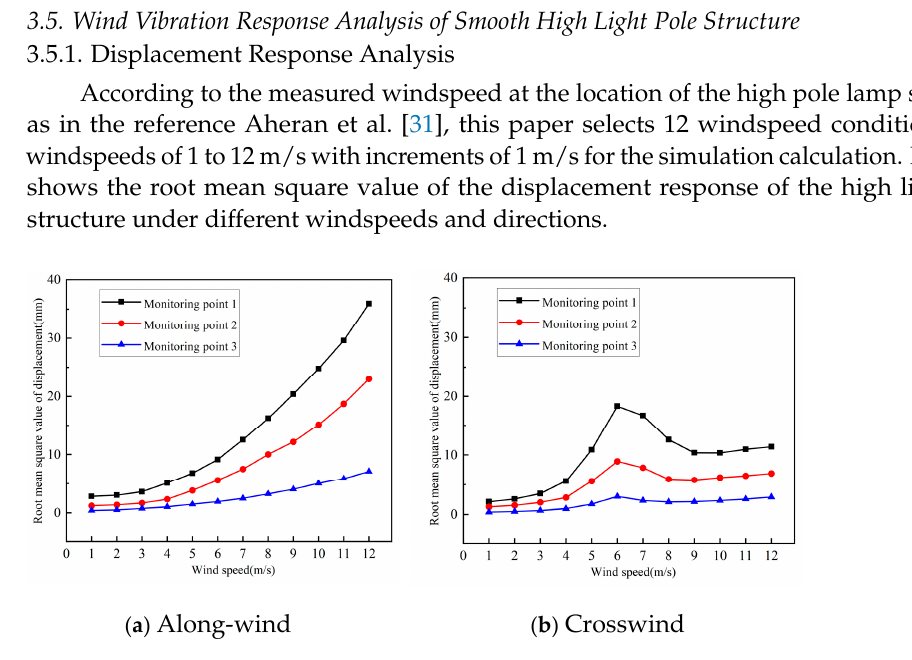
Figure 12. Root mean square value of displacement responses of the smooth light pole structure.